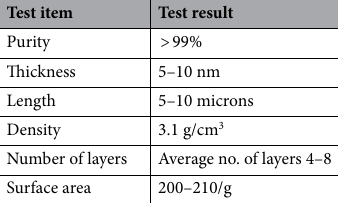
Table 2. Description of graphene.